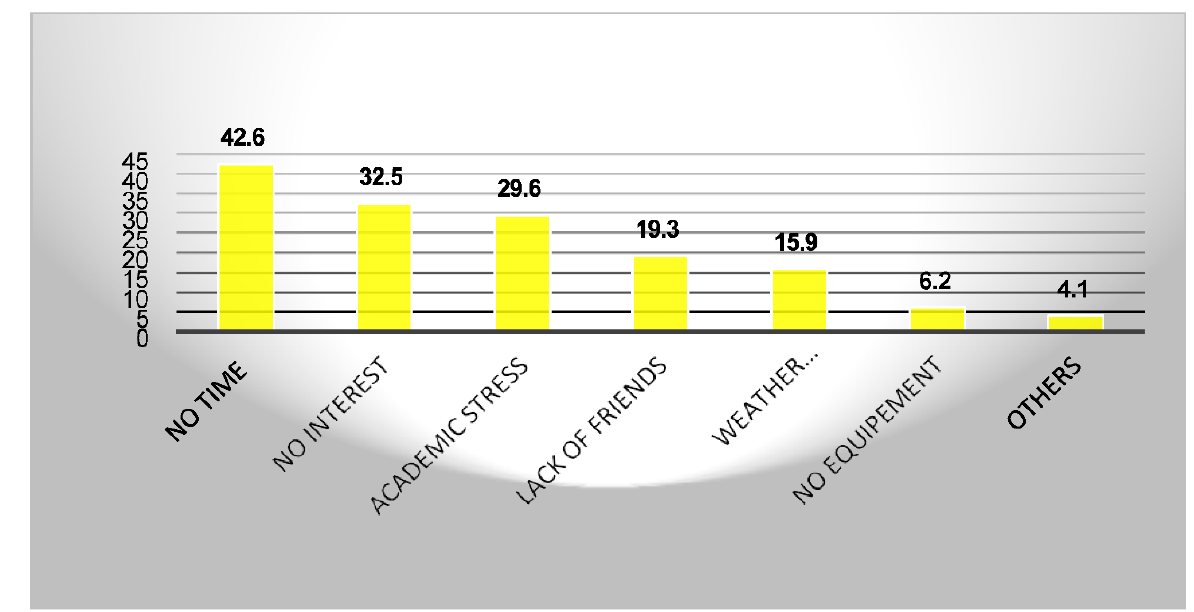
Figure 2. Reasons for not exercising.